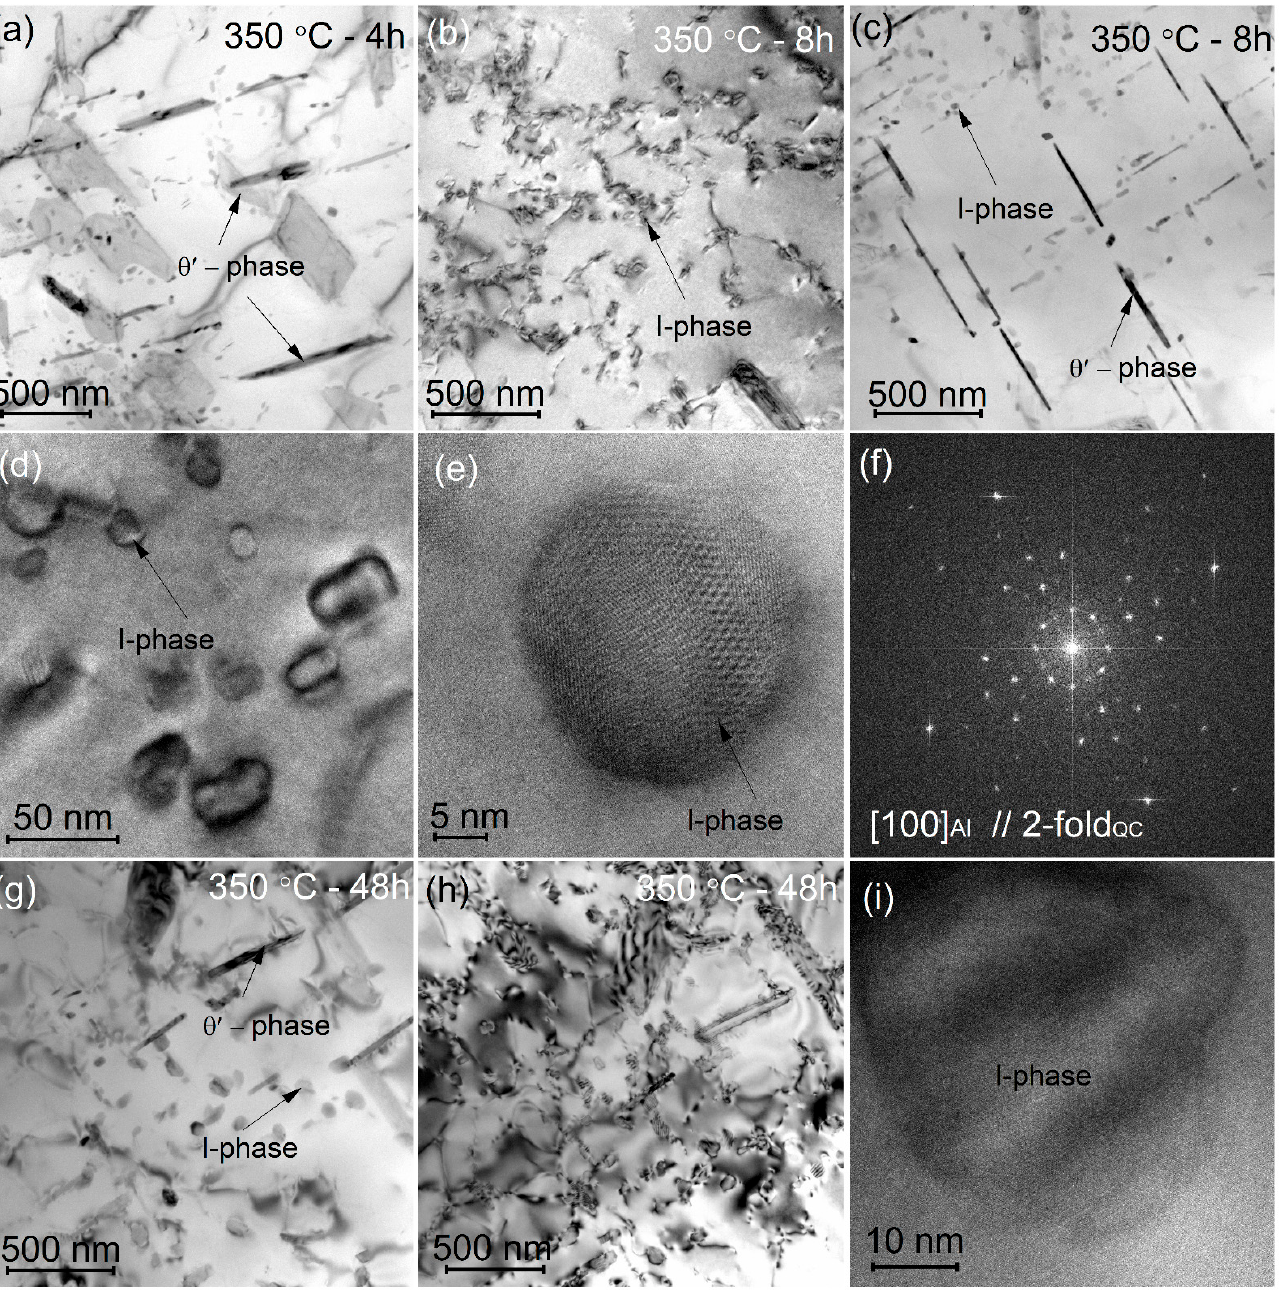
observed after peak aging for 32 h (SAEDs in Figure 7e,f). The length of the T -phase